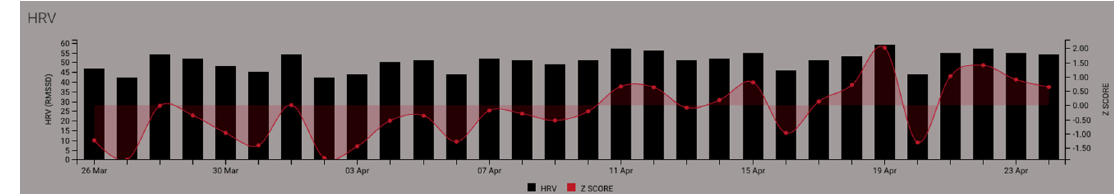
Figure 4. Example of daily heart rate variability (HRV) monitoring of a single individual using a rolling 28-day average to calculate daily Z-scores. Reduced root mean square of the differences in adjacent N-N intervals (rMSSD) and the respective Z-score values below 0 may suggest incomplete recovery, while Z-score values at or above 0 may suggest complete recovery status.